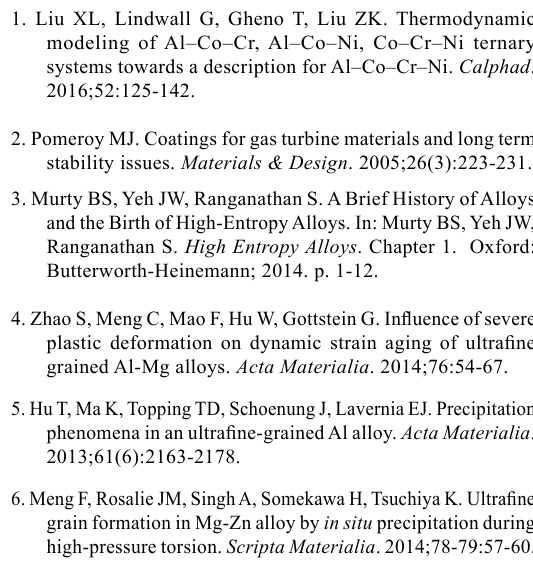
the microstructure and microhardness of the